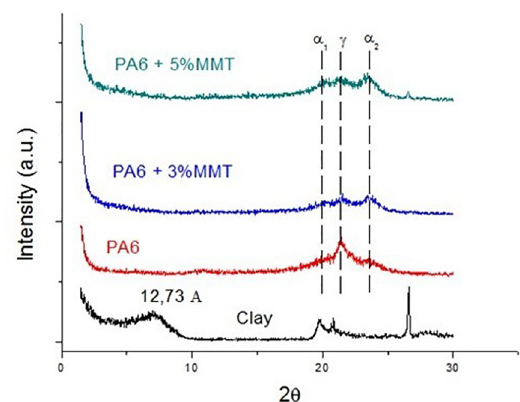
Figure 3. XRD patterns of the membranes PA6 and its nanocomposites with different clay content (3 and 5%)